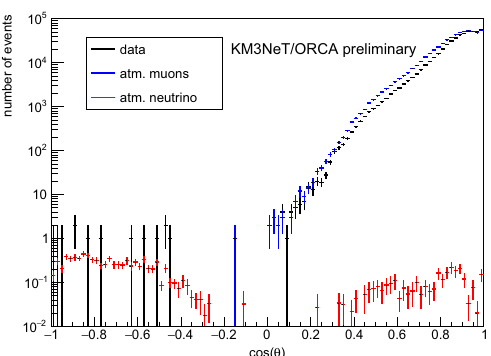
Figure 7. Angular distribution of events detected by the ORCA DU in a live time of 82 days, compared with Monte Carlo